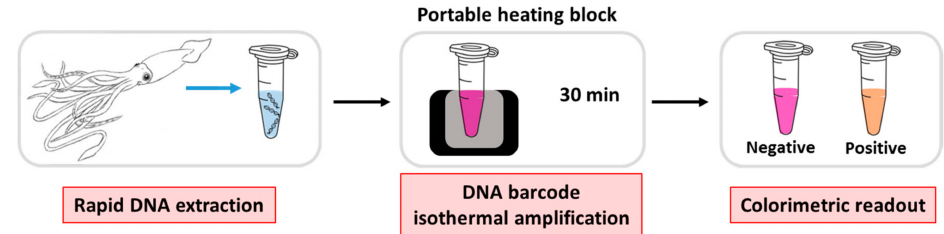
Figure 1. Schematic procedure of colorimetric loop-mediated isothermal amplification (LAMP) for cephalopod authentication. The proposed method consists of three steps: a rapid DNA extraction; the DNA barcode isothermal amplification process, performed at 63 ◦ C for 30 min; and the colorimetric readout, immediately visible at the end of the